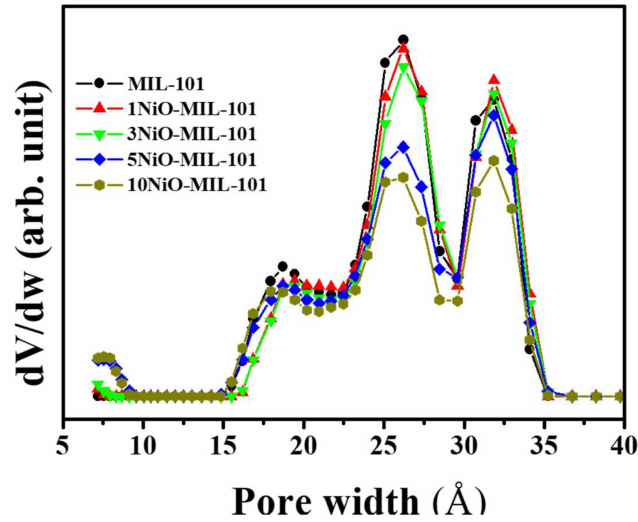
Figure 7. Pore-size distribution of MIL-101 with an increasing number of ALD cycles of NiO deposition. Reprinted with permission from Reference [101]. Copyright (2016)